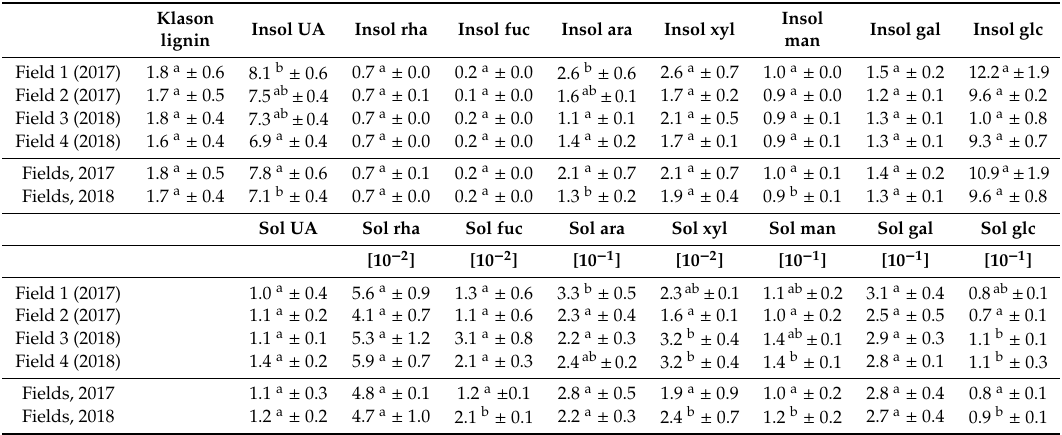
Table 2. Content of dietary fiber constituents (Klason lignin and sugar residues) in broccoli leaves from four